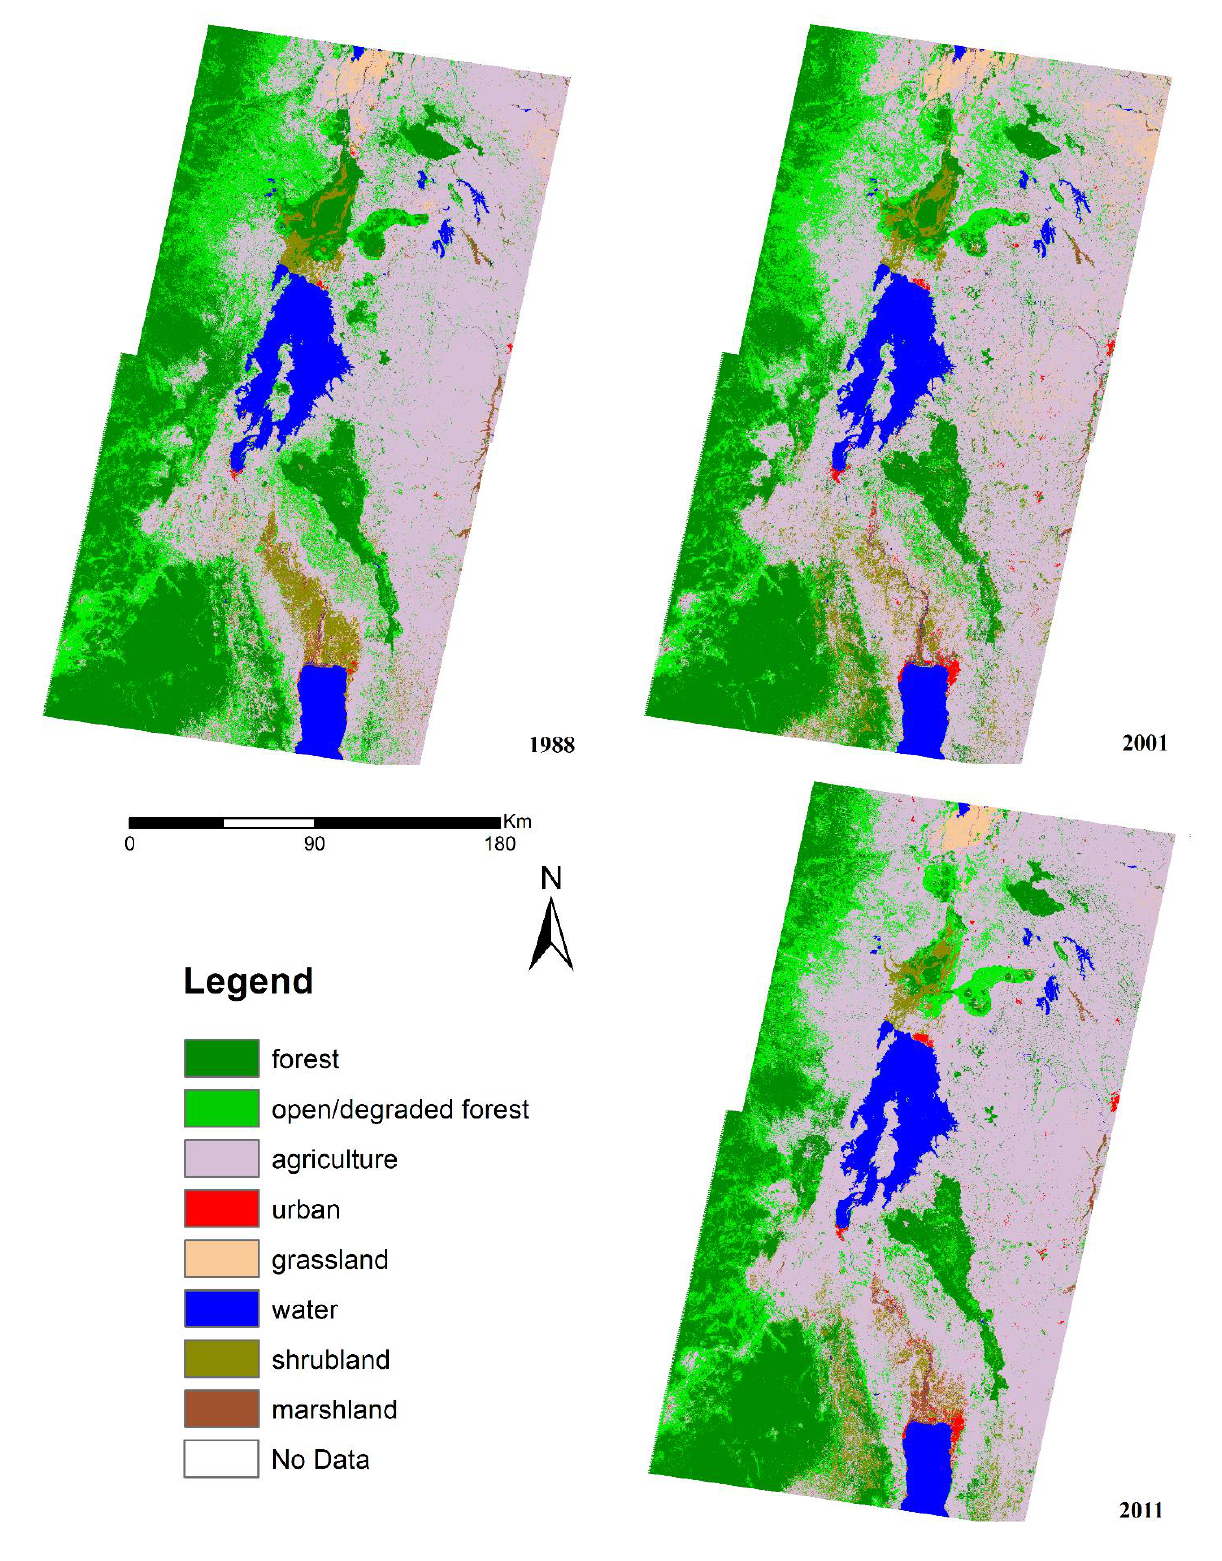
Figure 7. Time series of land cover maps of the study area for 1988, 2001 and 2011. The urban class was the smallest land cover in the region covering 11.6 kha (0.19%) of land area in 1988. The urban region increased by average rate of 1.3 kha per year during 1988–2001 and 0.29 kha per year after 2001. The urban region increase after 2001 may be in part due to replacement of